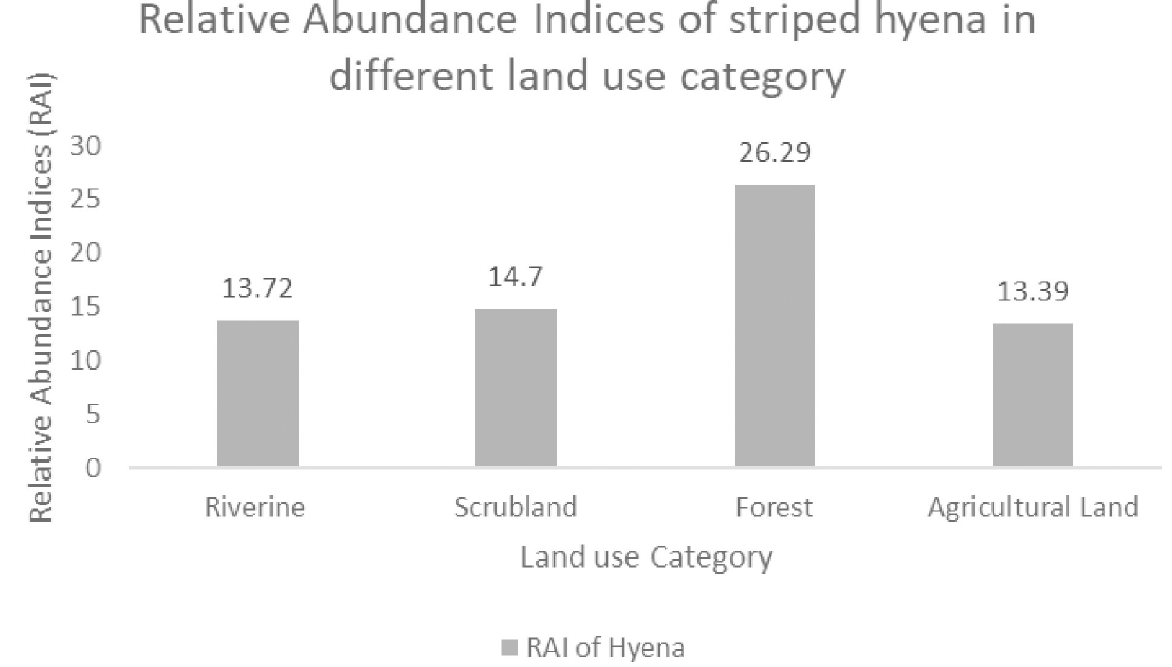
Fig 3. Relative abundance indices (RAI) of hyena in different land-use categories in human dominated landscape of Sawai Mansingh Wildlife Sanctuary, Rajasthan.